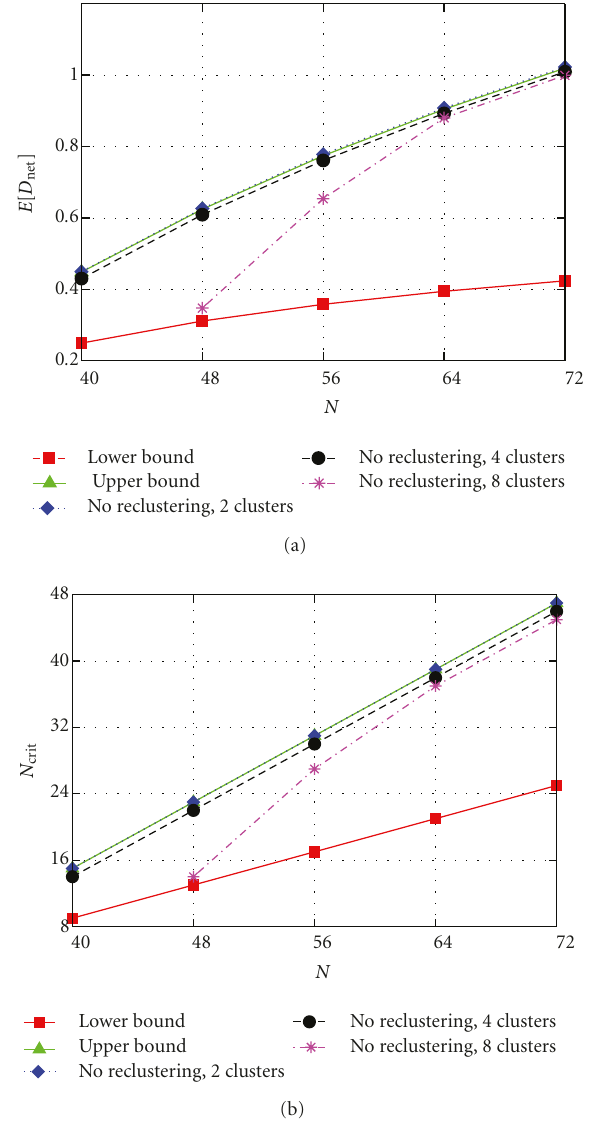
Figure 11: Sensor network performance using the proposed reclus- tering algorithm: (a) network lifetime and (b) critical number of deaths, as functions of the number of sensors. The performance in the absence of reclustering (with 2, 4, and 8 clusters, resp.) is and lower bound compared with the proposed upper bound UB D net = 10 − 3 and the sensor SNR is set to . The QoS condition is P ∗ LB D e net 5dB. The distribution of a sensor lifetime is exponential with μ =